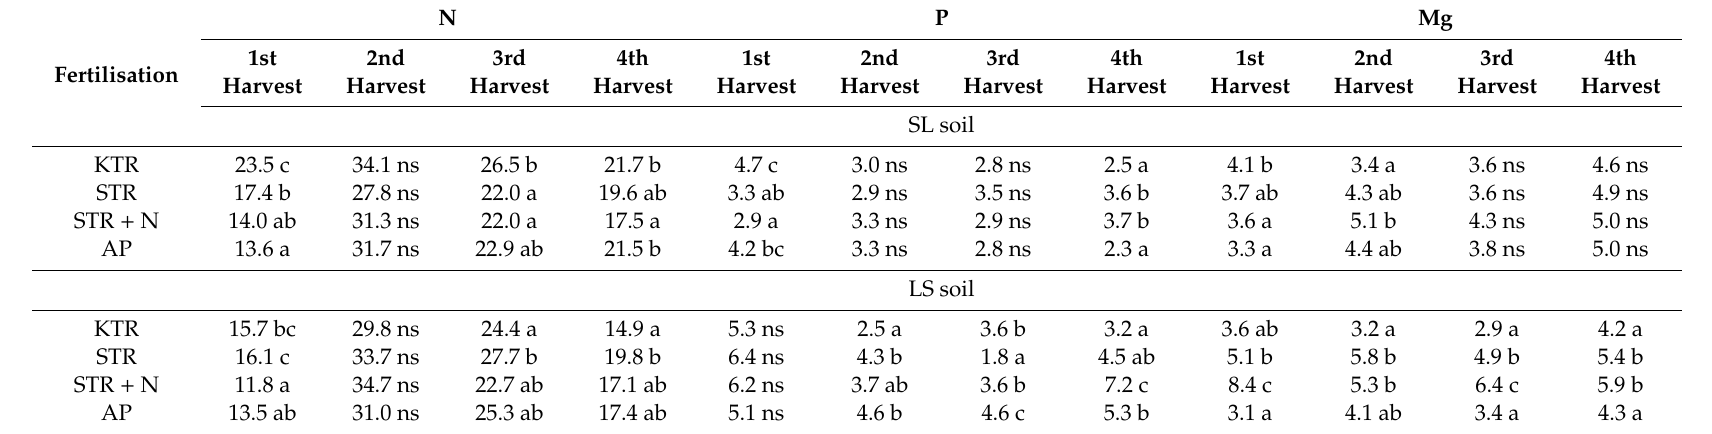
Table 2. Nutrients—nitrogen (N), phosphorus (P), and magnesium (Mg) content in plants in g kg − 1 D.M.